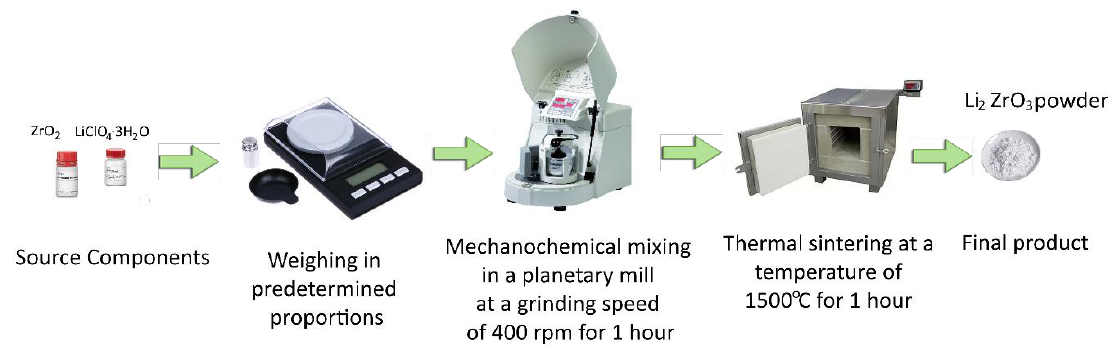
Figure 1. Schematic representation of the production of Li 2+4x Zr 4 − x O 3 ceramics.